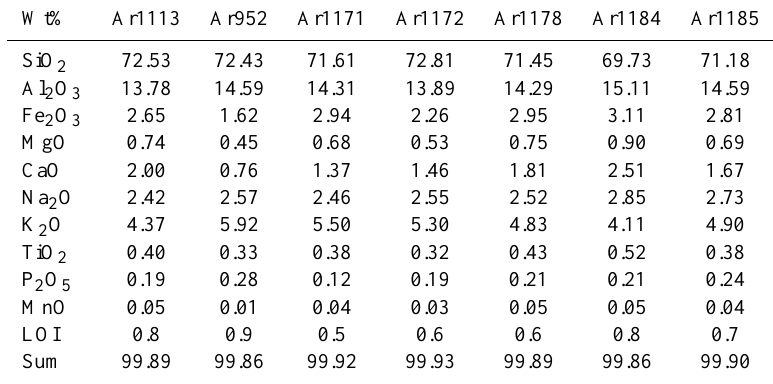
Table 4. Bulk rock composition of neosomes of representative anatectic